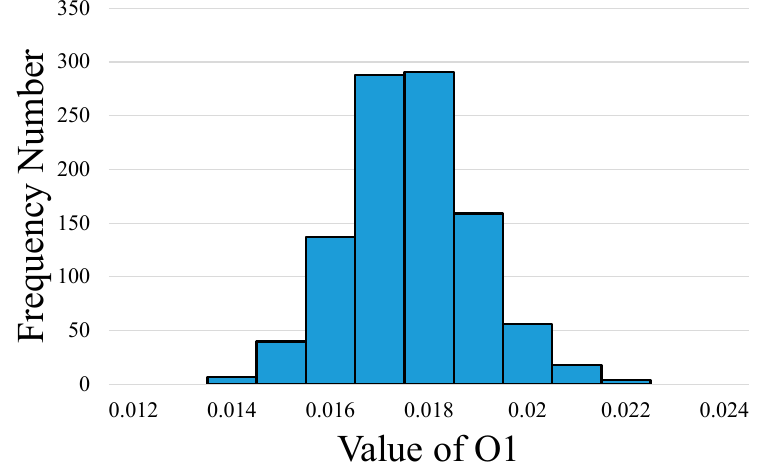
Figure 7. Results of the observability index O 1 corresponding to 1000 sets of random poses. The optimal measurement poses are used for calibration. During the calibration process, the variation of kinematic parameter errors during the iteration process are shown in Figure 8. Due to space constraints, only seven kinematic parameter errors related to the first hardpoint are given in the figure. After three iterations, the error value tends to be stable and the convergence speed of the calibration is fast. The identification results of all kinematic parameter errors are shown in Table 7.